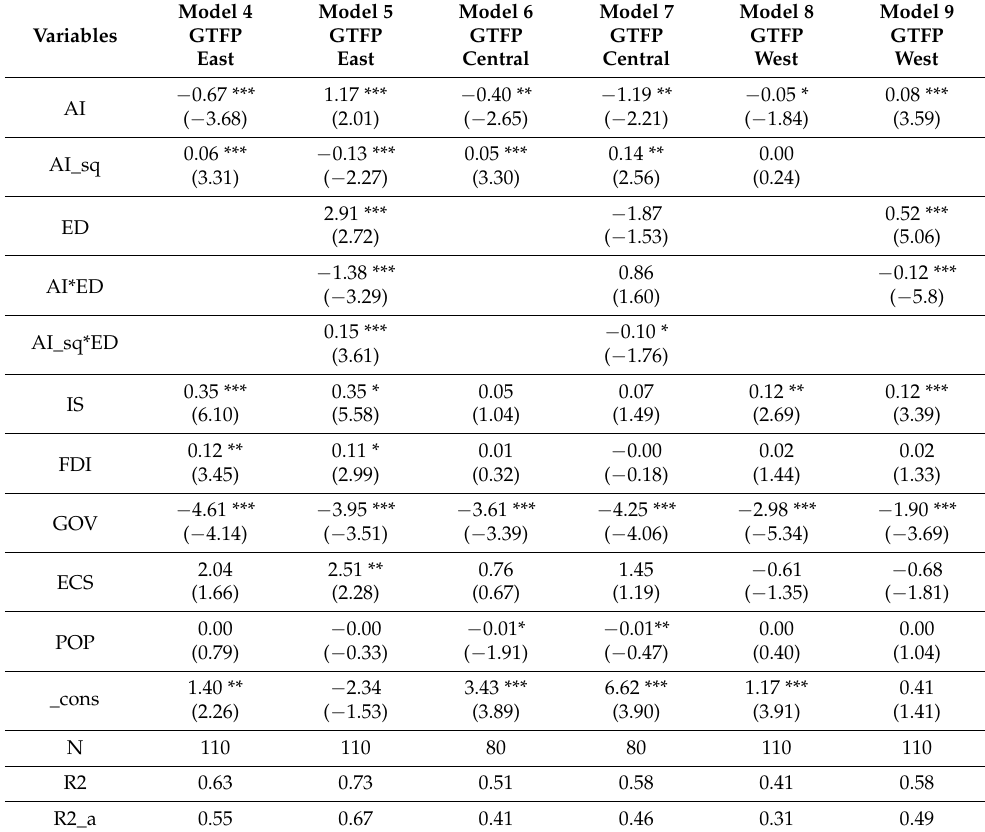
Table 4. Regional heterogeneity